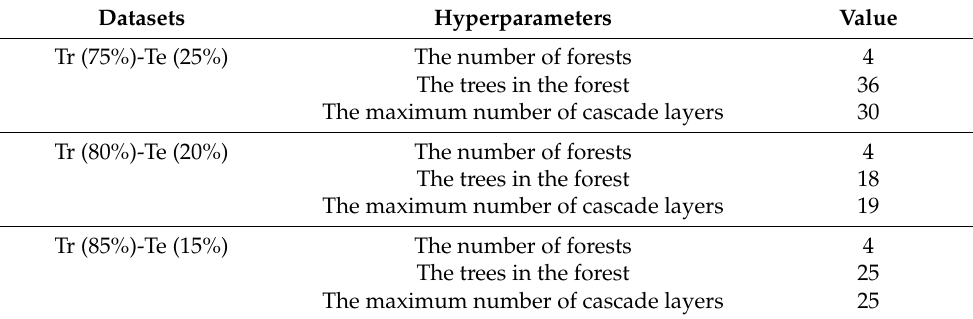
Table 7. The optimal hyperparameters in the DF